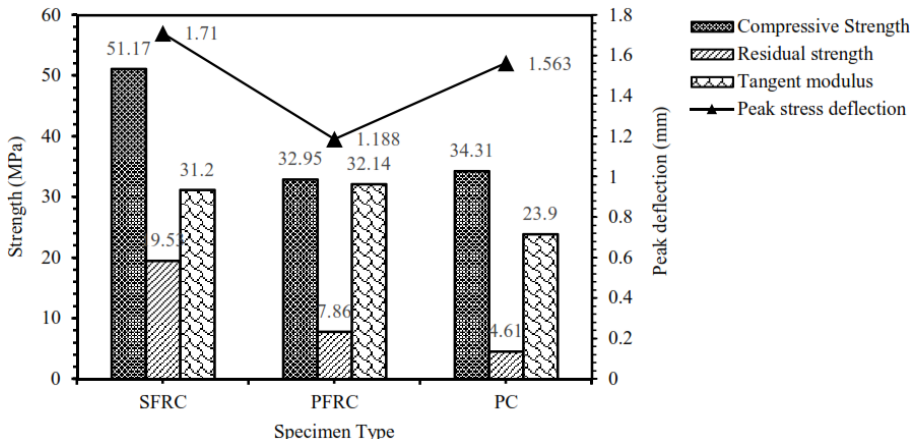
Figure 5: Several compressive features of the tested specimens